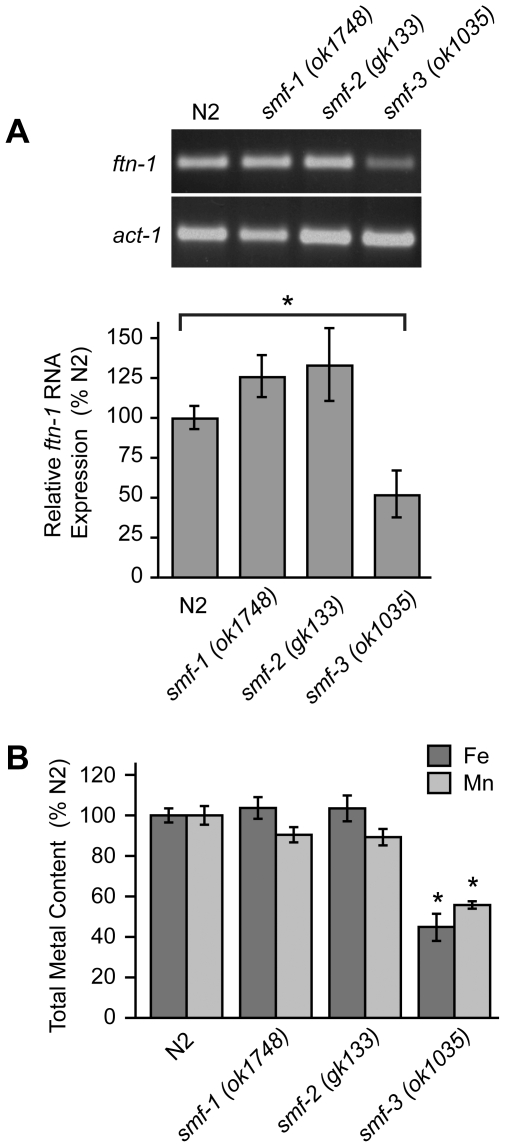
Total Fe content is reduced in smf-3(1035) mutant animals.(A) ftn-1 mRNA was quantified by RT-PCR from RNA isolated from N2 wildtype and smf-1(ok1748), smf-2(gk133) and smf-3(ok1035) strains. Relative changes in ftn-1 mRNA are expressed as a percentage of N2 wildtype animals after normalization to act-1 mRNA. Five independent experiments were performed and data are reported as means ± SEM, * p<0.05. (B) Total content of Fe and Mn in N2 wildtype and smf mutant animals determined by ICP spectroscopy is expressed as a percentage of N2 wildtype animals for each metal. At least three independent experiments were performed and the data are reported as means ± SEM, *p<0.01.